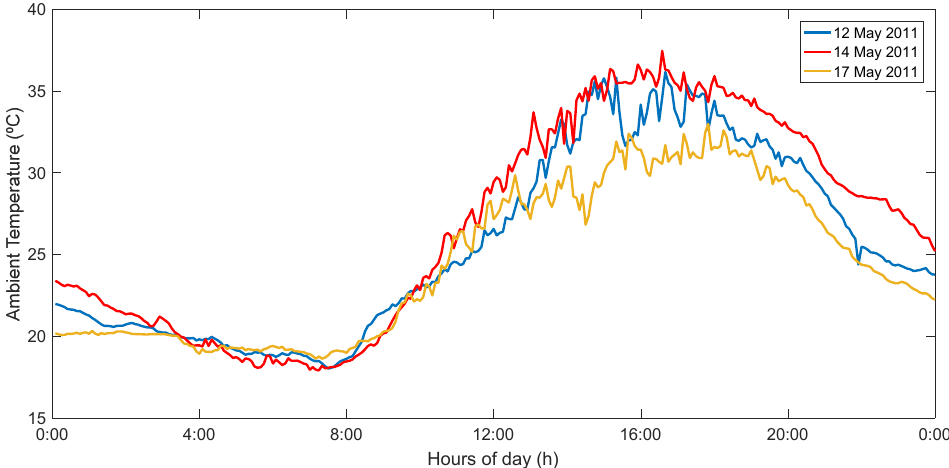
Figure 14. Daily profiles of total in-plane irradiance during 12, 14 and 17 May 2011.